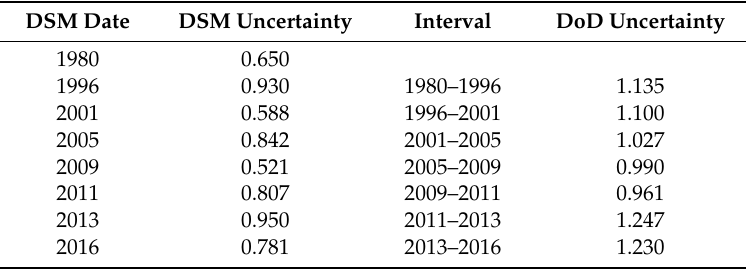
Table 4. Z errors and vertical uncertainties of the models (DSMs and DoDs) 1